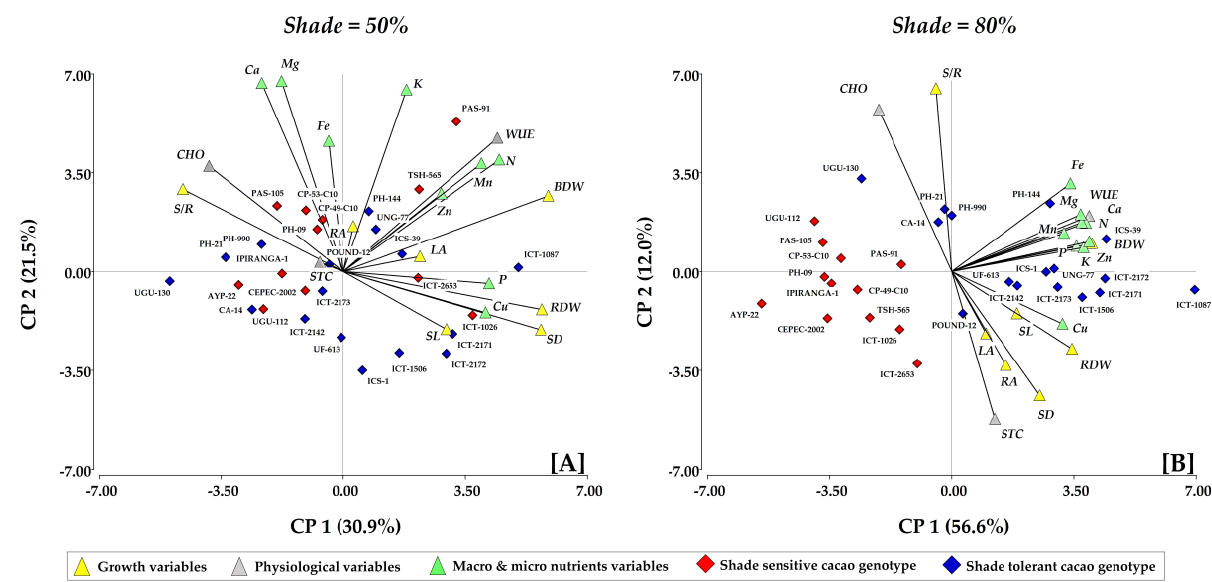
Figure 6. PCA analysis of shade effect on growth, physiological parameters, and nutrient uptake of shade-sensitive and tolerant genotypes, subjected to 50% shade ( A ) and 80% shade ( B